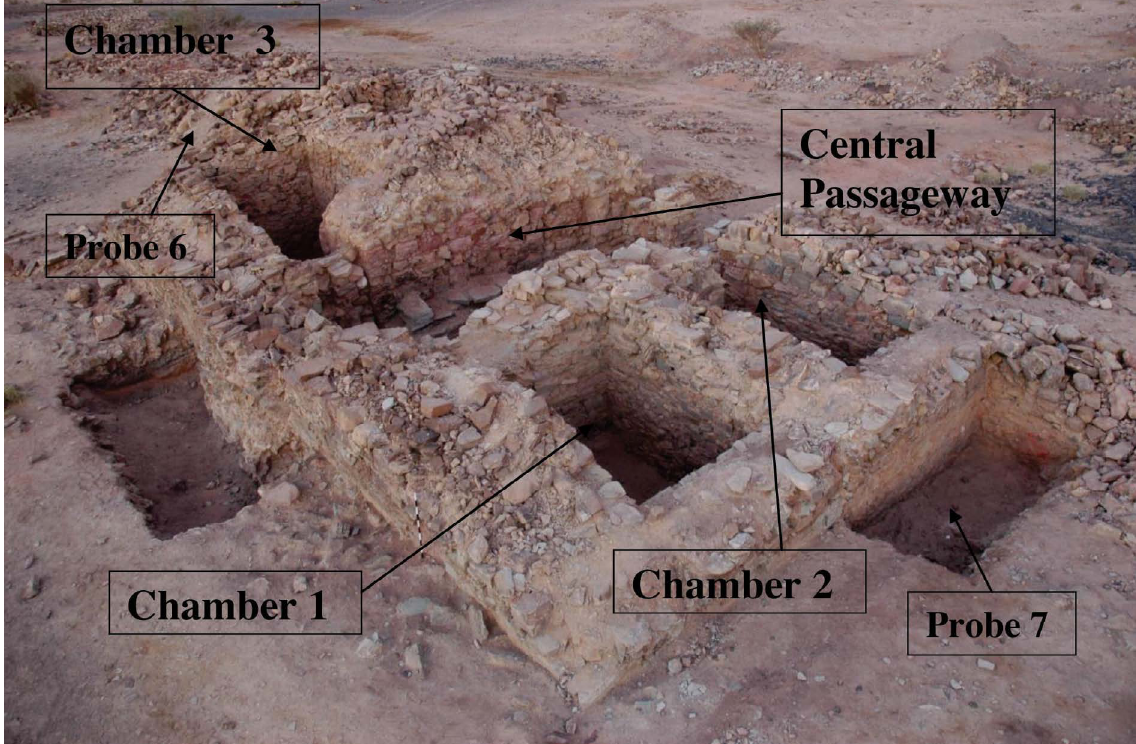
Figure 5. 2006 Khirbat en-Nahas excavation - Area A. Excavation area shown ca. 25 x 5 m. (Source: Levy et al.